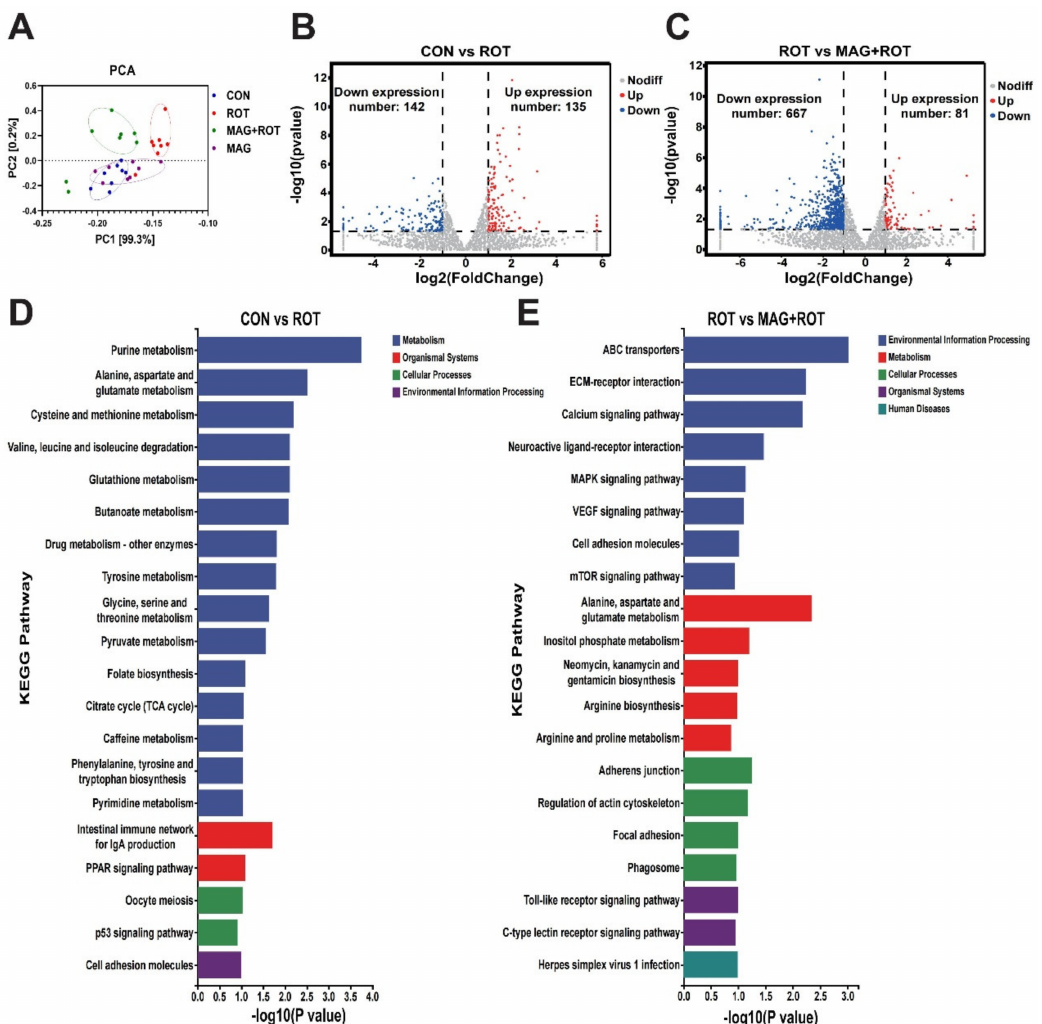
Figure 2. Effect of magnolol on transcriptome of broilers induced by rotenone. ( A ) Principal com- ponent analysis for all groups. Volcano plot of differentially expressed genes in jejunum tissues of the CON group and ROT group ( B ), ROT group and MAG + ROT group ( C ). The x—axis and y—axis indicate log2 (fold change) and 2log10 (FDR) of differentially expressed genes in jejunum tissues, respectively. The red color represents upregulated genes, and the blue color represents downregulated genes. Top 20 enriched KEGG terms of differentially expressed genes in the CON group were compared with ROT group ( D ) and ROT group compared with MAG + ROT group ( E